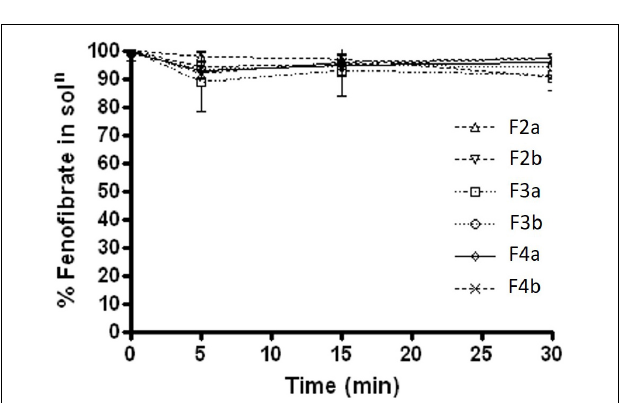
rate than F3b (35% drug precipitated) and in a similar way F4a (80% drug precipitated within 16 hrs of time) had significant precipitation rate than F4b (38% drug precipitated after 24 h) ( Figure 4